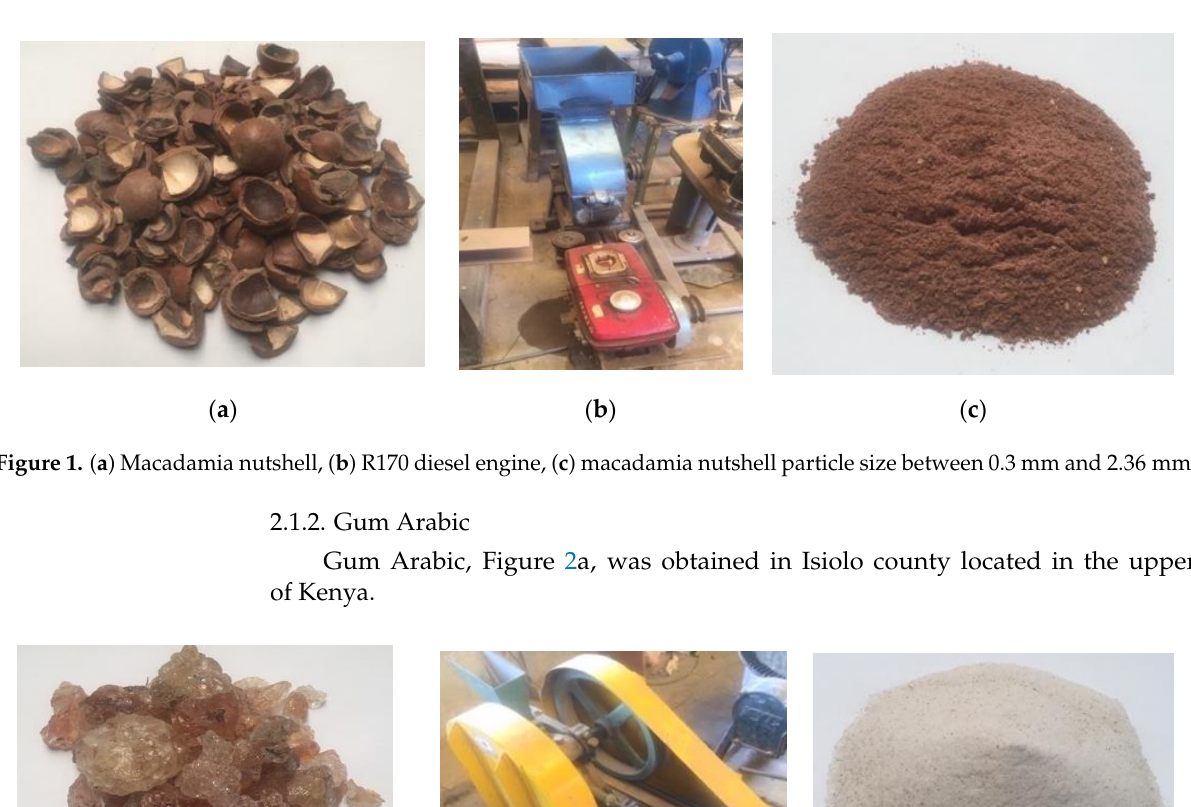
Figure 1. ( a ) Macadamia nutshell, ( b ) R170 diesel engine, ( c ) macadamia nutshell particle size between 0.3 mm and 2.36 mm.